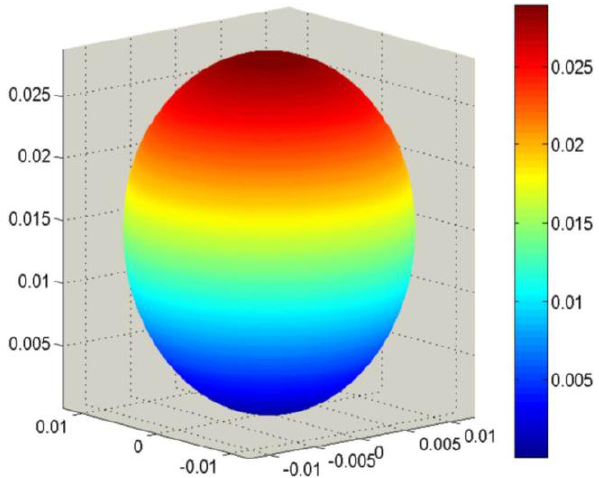
Figure 9. Longitudinal surface representation, g ( h ), for the voltage piezoelectric constant of a PMN-PT textured polycrystal.